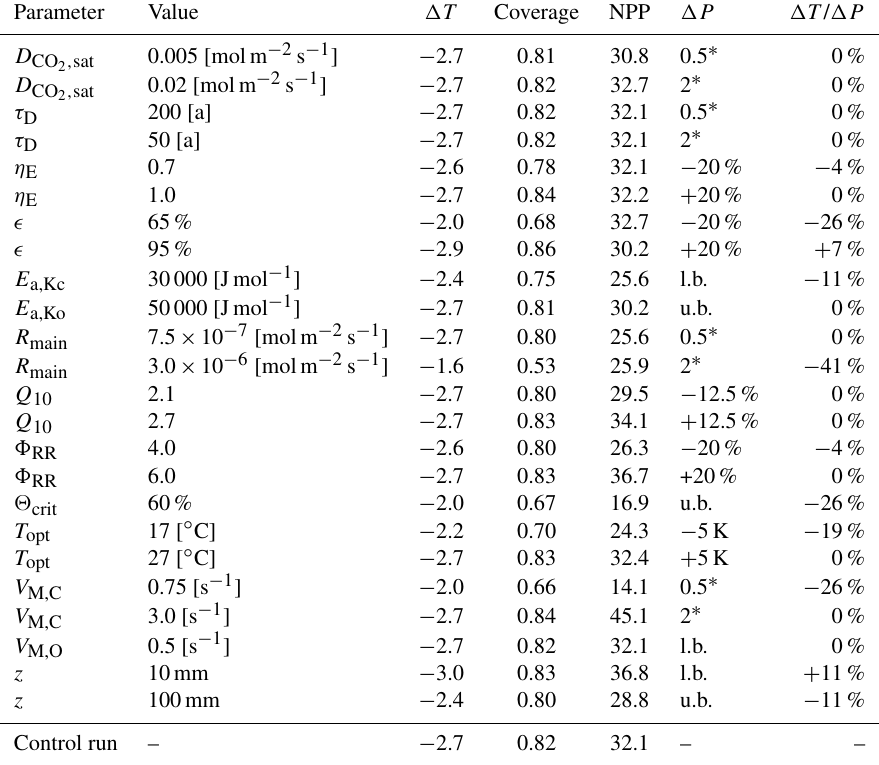
Table A1. Sensitivity of the estimated topsoil temperature difference due to the addition of a dynamic bryophyte and lichen layer to the parameterisation of the bryophyte and lichen PFT. See Sect. 2.2 for a description of the parameters. (cid:49)T is the temperature difference in the uppermost soil layer between the Dynamic simulation and the Without one (Sect. 2.2). NPP is in gm − 2 a − 1 of carbon. (cid:49)P stands for a change in a model parameter, either by multiplication with a factor ( ∗ symbol), percentage change or by setting the parameter to the upper boundary (u.b.) or lower boundary (l.b.). (cid:49)T / (cid:49)P is the percentage change in temperature difference ( (cid:49)T ) due to a change in a model parameter ( (cid:49)P ) compared to the control run. The sensitivity analysis is performed on a single grid cell of JSBACH (see Sect. 2.2 for